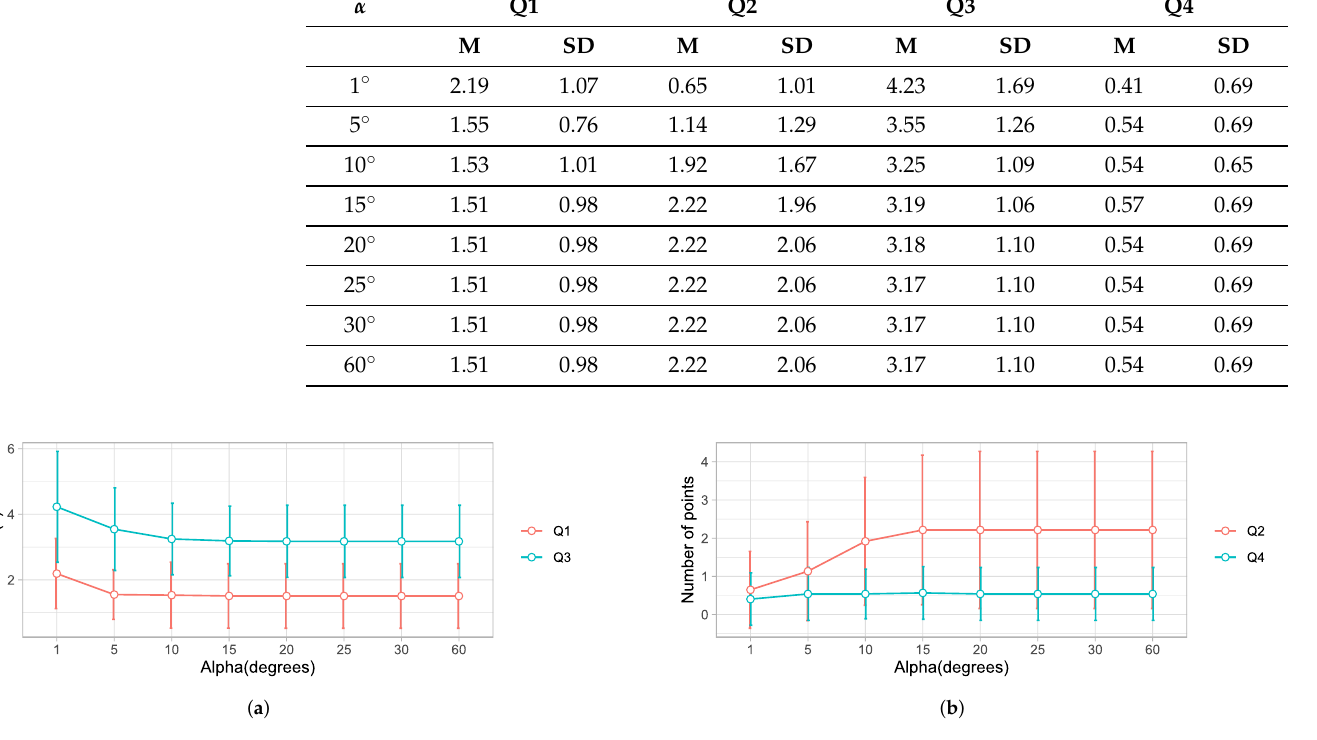
Figure 15. Investigating the effect of the eye-gaze threshold using different values of α . ( a ) Q1: The time taken by the strategy to detect the desired point. Q3: The time taken by the robot to reach the desired point. ( b ) Q2: The number of intermediate points detected by the strategy. Q4: The total number of intermediate stopping points of the